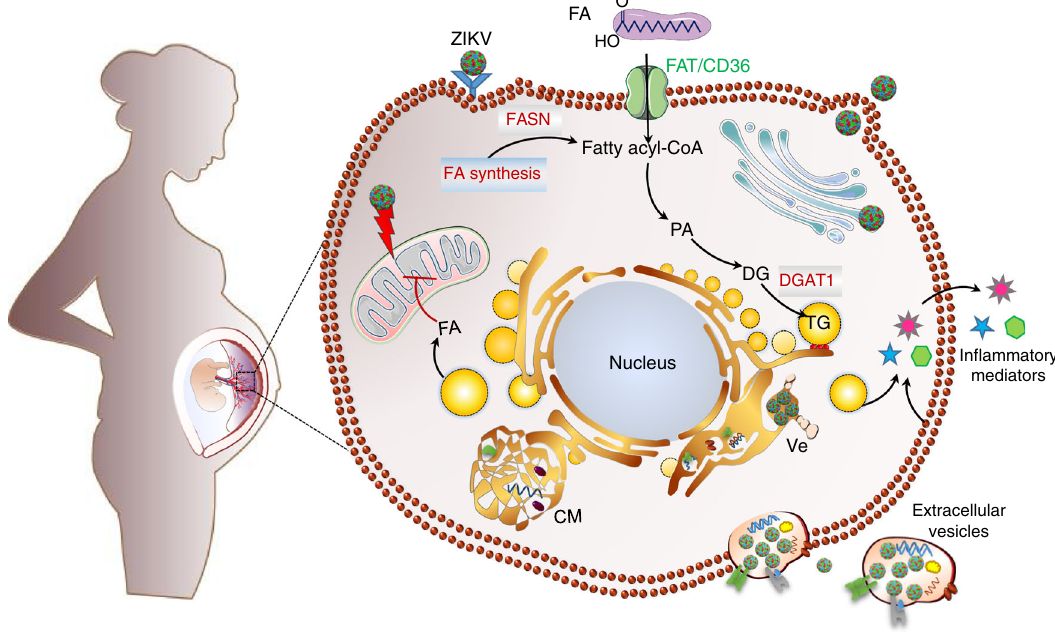
Fig. 10 Summary of ZIKV-induced metabolic reprogramming of human placenta and specialized hubs that contribute to ZIKV life cycle. By increasing placental lipid overload, ZIKV deprives the fetus of essential lipids and contributes to massive in fl ammation which may further impair the barrier function of the